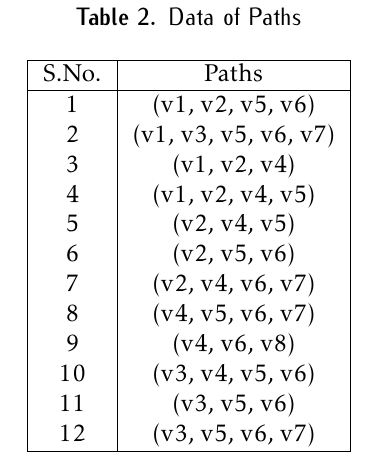
Figure 2. Directed Graph, G